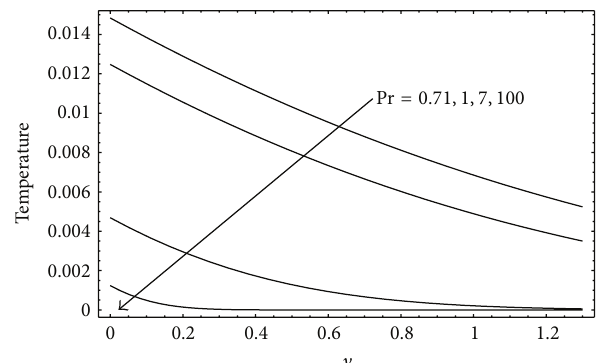
Figure 11: Temperature profiles for different values of 𝑡 when 𝑅 = 1, Pr = 0.71 , and 𝛾 = 1 .